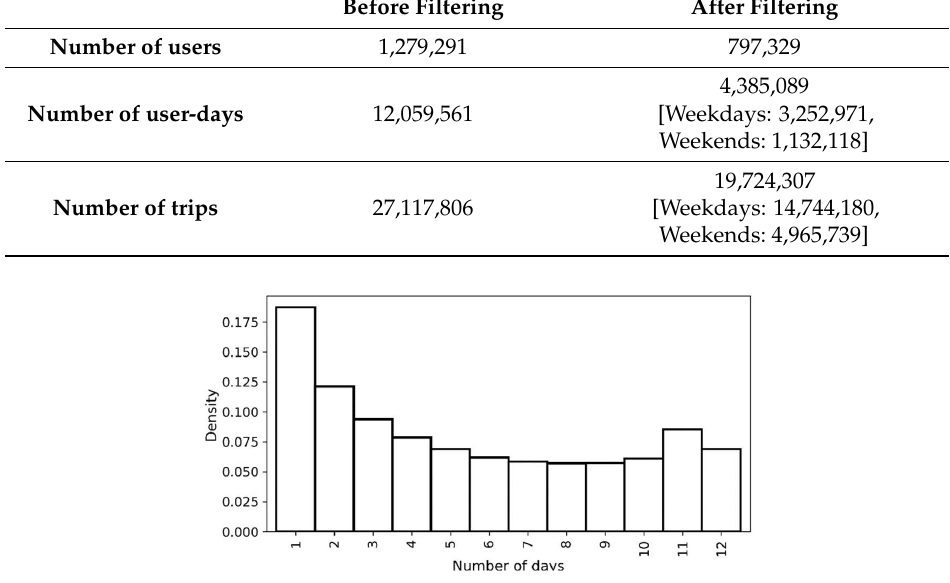
Figure 8. Number of valid days per user.